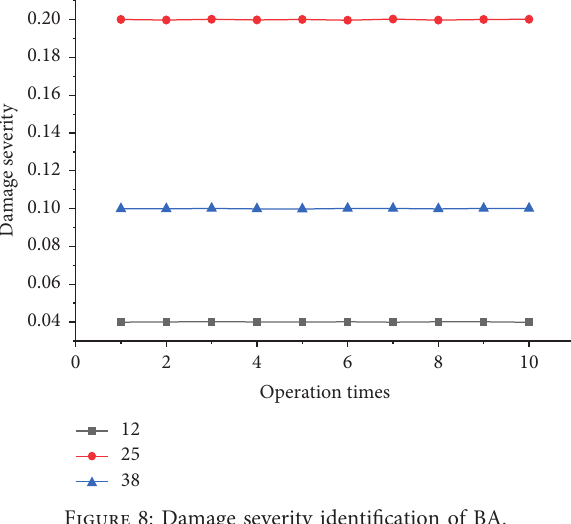
Figure 8: Damage severity identification of BA.